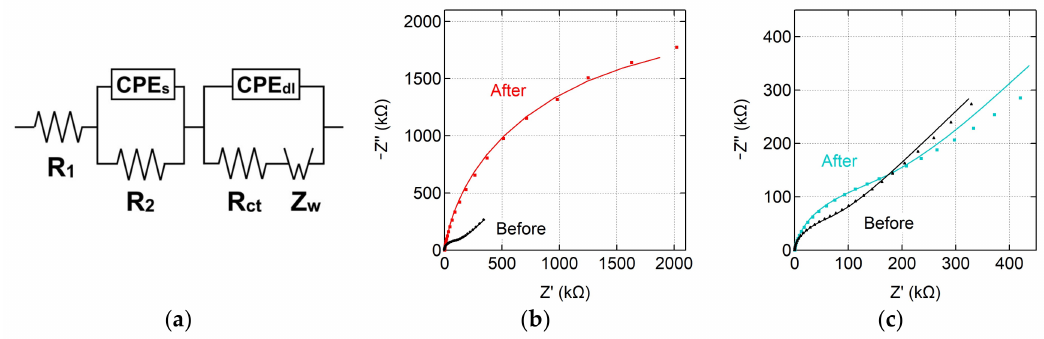
Figure 8. ( a ) Equivalent circuit model used for fitting Nyquist plots. ( b , c ) Nyquist plots obtained at monolayer graphene electrode before and after ( b ) covalent and ( c ) noncovalent modification in 0.1 M PBS containing 1 mM FcDA. Solid lines represent fitted